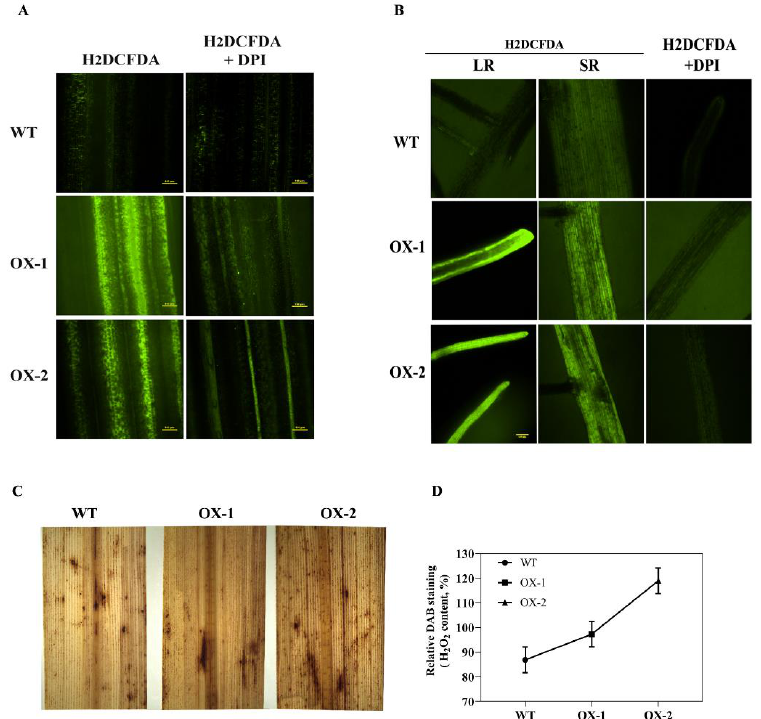
Figure 2. Representative images showing the effect of altered expression of OsRACK1B on H 2 O 2 accumulation in rice leaves ( A , C ) and roots ( B ). ( A , B ) H 2 DCFDA staining (green fluorescence) alone or plus DPI of the leaf sheaths (50 µM) and roots (10 µM) of eight-week-old wild-type and OsRACK1B-overexpressed rice plants. A fluorescence microscope was used for the detection of H 2 O 2 fluorescence. LR, lateral root; SR, seminal root. Bars = 100 μm. ( C , D ) DAB staining shows DAB polymerization product (dark brown spots) in the fully expanded leaf of eight-week-old wild-type and OsRACK1B-overexpressed (OX) rice plants ( C ) and the relative quantity of spots developed after 72 h of DAB staining measured by ImageJ (imagej.nih.gov/ij, accessed on 31 October 2019). 2.3. OsRACK1B Regulates Rboh and SOD Activity Given that H 2 O 2 accumulation was observed in OsRACK1B-OX plants, we investi- gated the in-gel activity assay of crude protein extracts from the leaves of transgenic and WT plants. Interestingly, the gel activity using NAPDH as a substrate revealed a different migration pattern in the OsRACK1B-OX samples than that of the wild-type (Figure 3A). While the WT fractionated samples produced a formazan band of 80 to 75 kD molecular masses, the OsRACK1B-OX samples had approximately 103 kD-sized bands. As the RBOH activity assay is based on the migration of enzyme complexes through native gels, we conclude that the RBOH enzyme activity in OsRACK1B-OX leaves is different to that of the wild-type plant. To further confirm the Rboh assay, the WT sample was tested for sensitivity to DPI (Rboh/NADPH oxidase inhibitor, 50 µM), and we observed a complete inhibition of Rboh activity (Figure 3A, lane 4, +DPI). These data provide further evidence that OsRACK1B is regulating OsRboh activity, possibly at the post-transcriptional or post- translational levels. Remarkably, several reports suggested that overexpression of Rboh does not result in constitutive ROS production but, rather, a post-transcriptional or post- translational processing such as phosphorylation that activates Rboh for the ROS burst